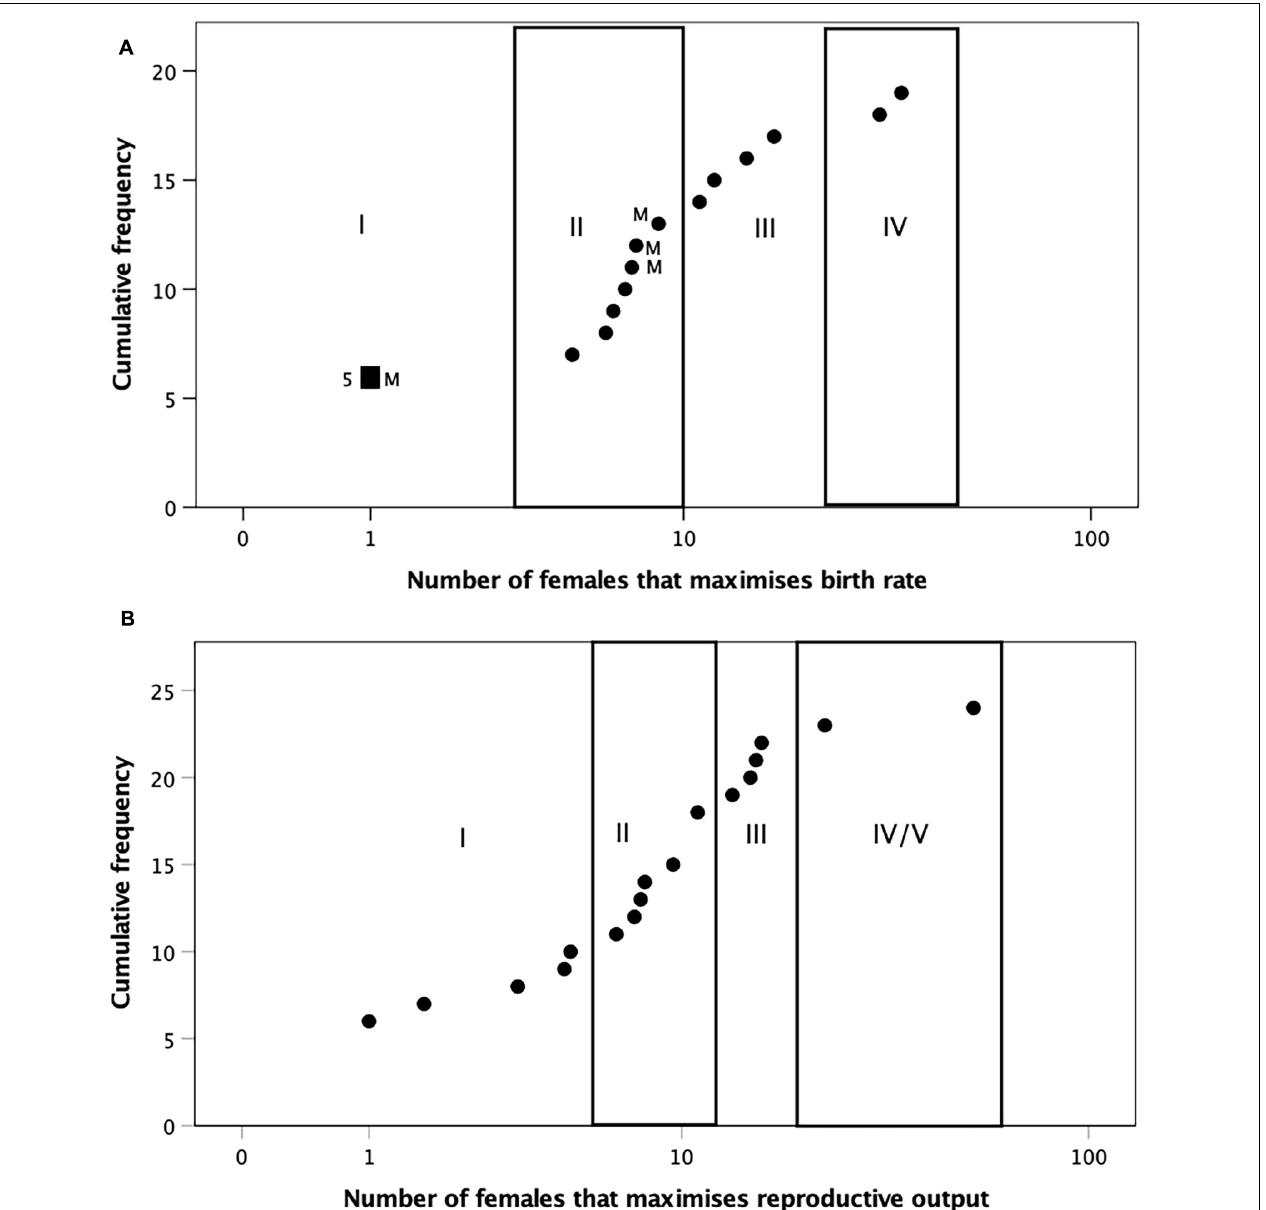
FIGURE 8 | Cumulative distributions of the number of females that maximise (A) birth rate in mammal genera (from Figures 2– 4 ) and (B) reproductive output in primate genera (from Figure 5 ). The clusters identified by a k- means cluster analysis in each case are identified by the Roman numerals. In (A) , M denotes non-primate mammals; the large square with the adjacent numeral 5 denotes five non-primate mammal genera at the same